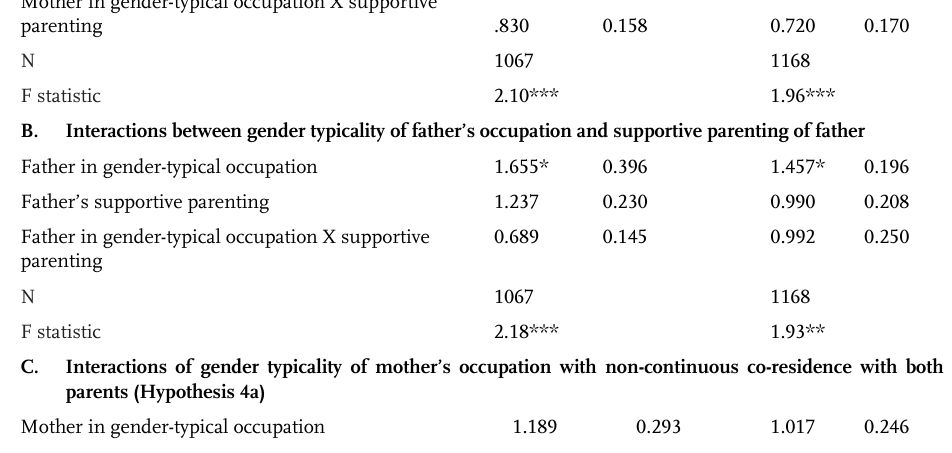
Girls Boys Standard Standard OR OR error